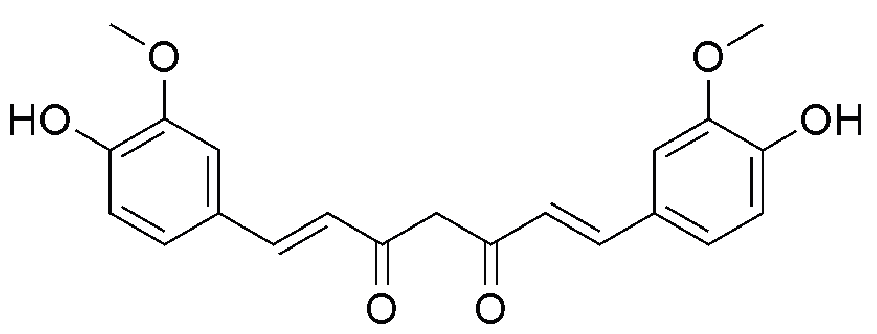
Figure 1. Chemical structure of